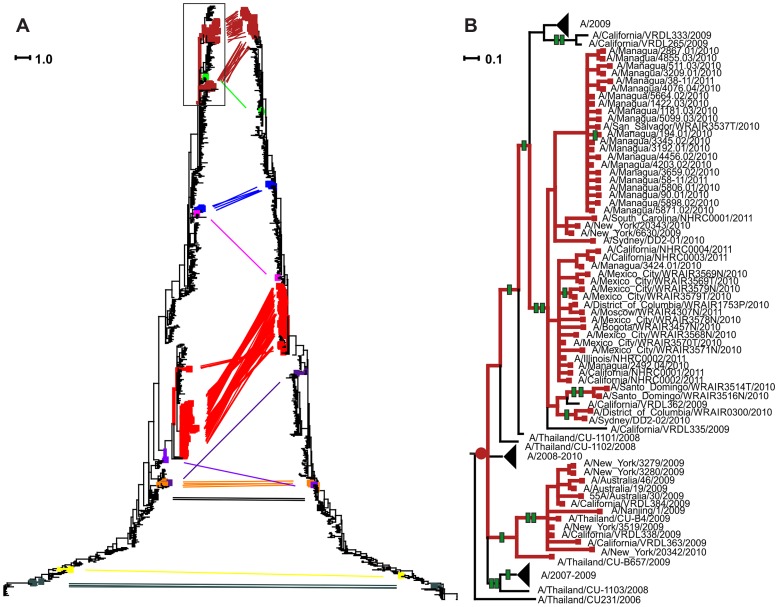
Reassortment events inferred from comparison of phylogenies of HA and NA segments of Influenza A H3N2 virus, and subsequent accumulation of amino acid replacements.(A) The tanglegram [77] of the NA (left) and HA (right) genes for the same set of strains. Topologies of the phylogenies of the two genes are incongruent; such incongruence can be resolved by assuming reassortments. The clades corresponding to inferred reassortments are shown in color, with the lines of the corresponding color connecting the inferred reassortants for the two genes. (B) Zoom-in of the clade in rectangle in A. Red dot, inferred RCB (node id 62); green hatches, amino acid replacements on internal branches following the RCB. Some clades are collapsed into black triangles for clarity, and substitutions on such clades are not shown.